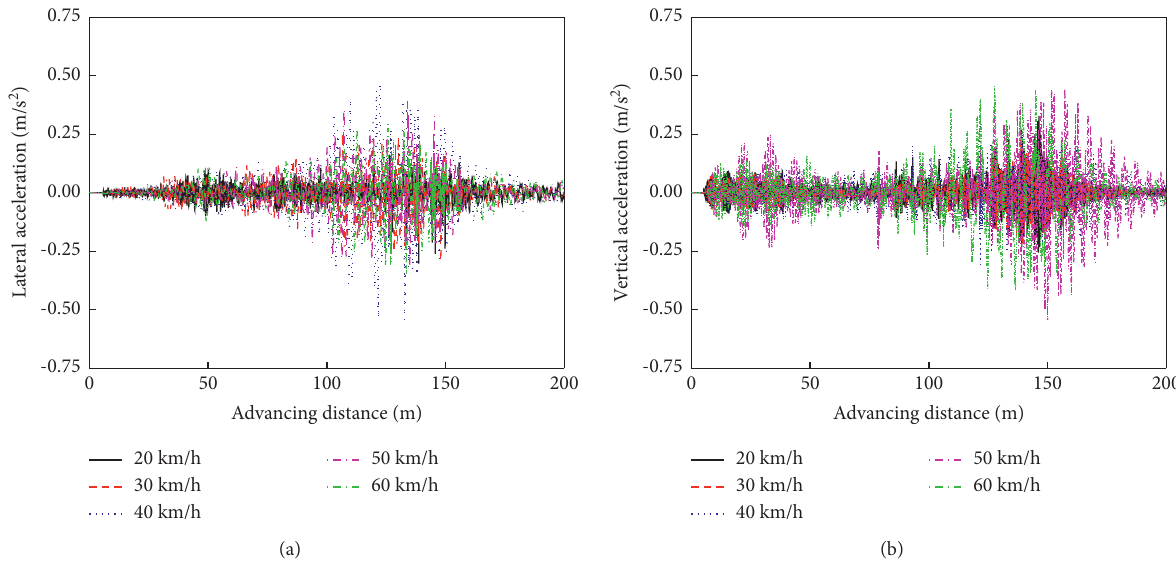
Figure 10: Comparison on time history of midspan accelerations of landscape footpath at different vehicle speeds. (a) Lateral. (b) Vertical. Table 3: Midspan acceleration values of landscape footpath at different vehicle speeds.